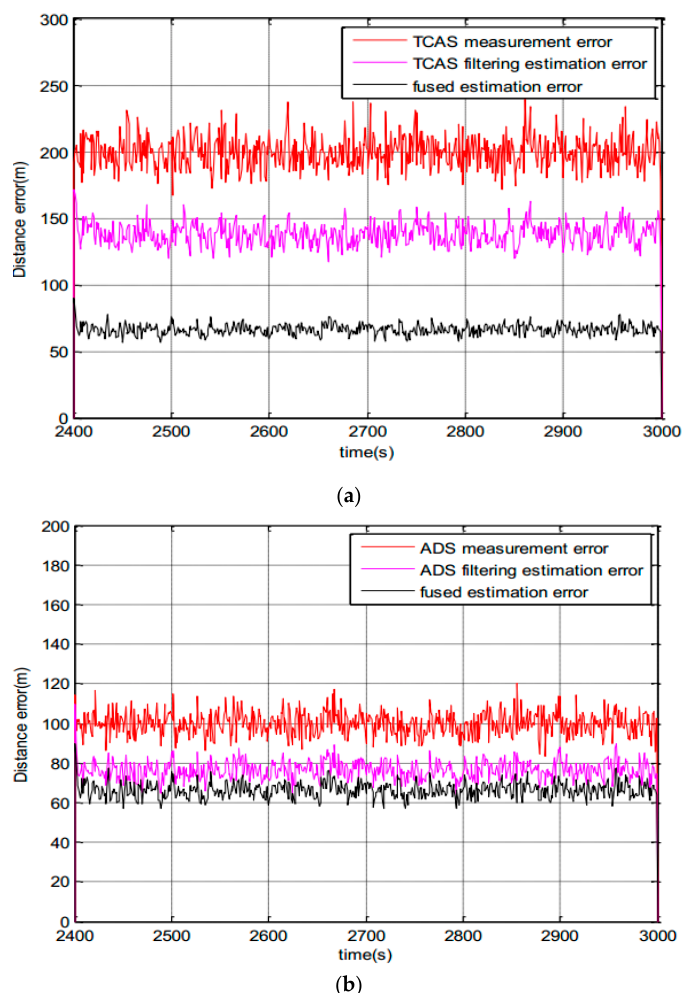
Figure 9. Measurement noise and fusion estimation noise. ( a ) Measurement noise and fusion estimation noise of TCAS; ( b ) measurement noise and fusion estimation noise of ADS-B.